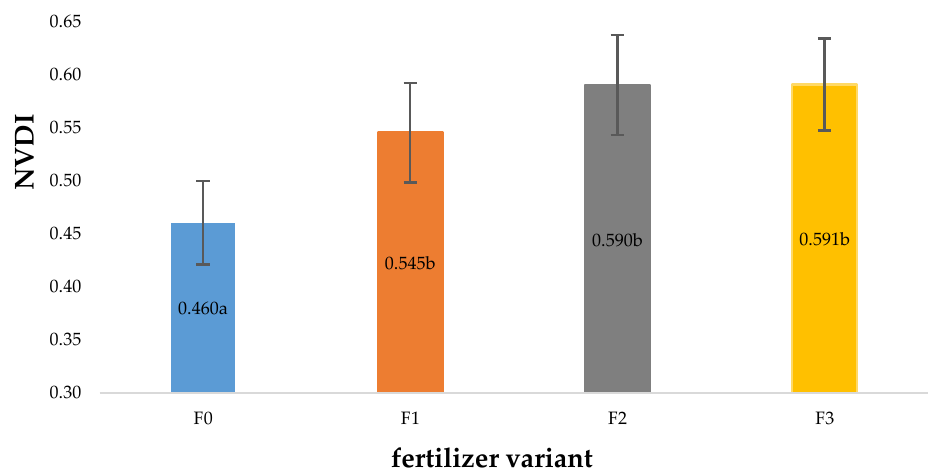
Figure 4. Normalized Difference Vegetation Index (NDVI) on July 13, depending on the fertilization used. Note: F0 — control; F1 — foliar fertilization; F2 — localized fertilization: microgranules for precision application into the soil; F3 — local- ized fertilization: microgranules for precision application into the soil with foliar fertilization. Differences in the results between Normalized Difference Vegetation Index for fertilization variant are marked with different small letters, p < 0.05.